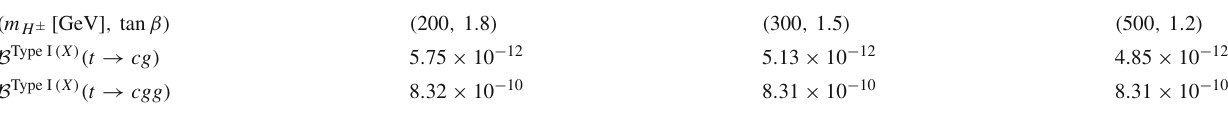
Table 4 The branching ratios of t → cg and t → cgg decays in the type-I (type-X) 2HDM, with three sets of input parameters of ( m H ± , tan β) extracted from Ref.